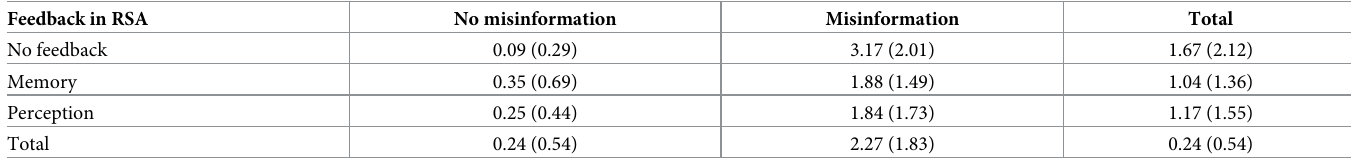
Table 1. Means ( SD s) of number of answers consistent with misinformation across experimental conditions in Experiment 1 (range: 0–6). Feedback in RSA